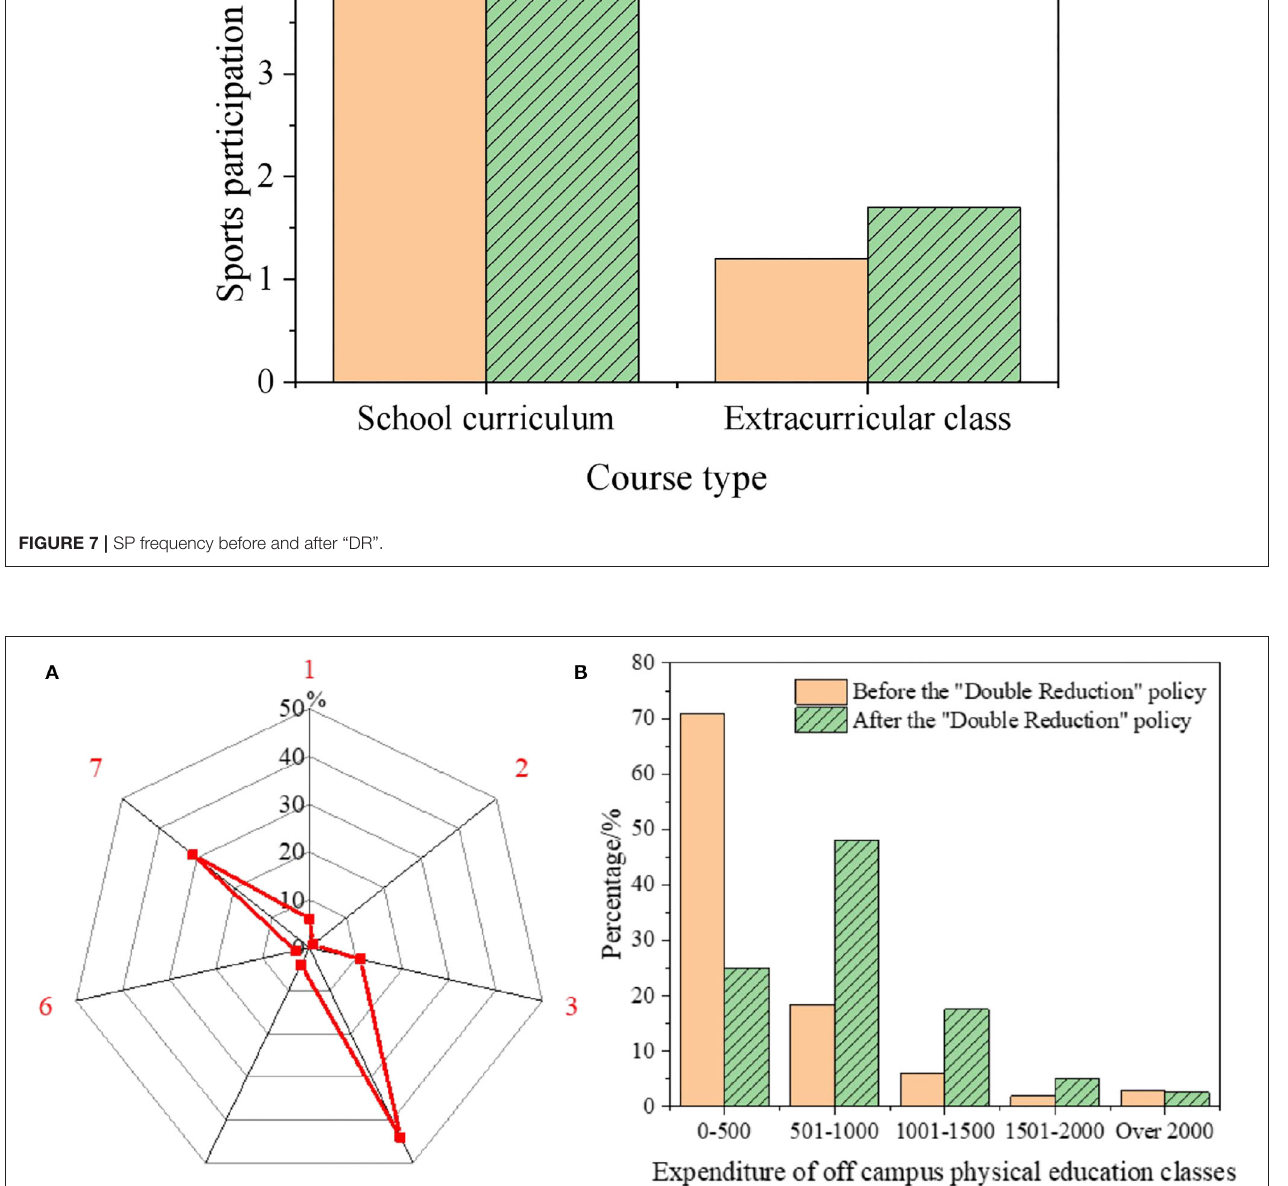
Frontiers in Psychology |